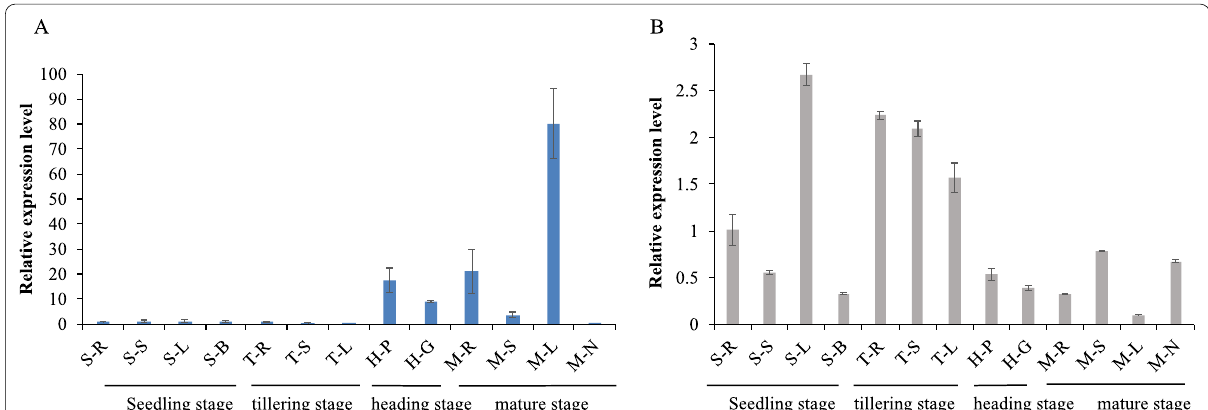
Fig. 1 Analysis of the miR528 and D3 genes expression pattern in rice. A Expression pattern analysis of miR528 in various tissues by qRT-PCR. B Expression pattern analysis of D3 in various tissues by qRT-PCR. S-R, root at the 7-day seedlings; S-S, stem at the 7-day seedlings; S-L, leaf at the 7-day seedlings; S-B, stem base at the 7-day seedlings; T-R, root at the tillering stage; T-S, stem at the tillering stage; T-L leaf at the tillering stage; H-P, Panicles at the heading stage; H-G, glume at the heading stage; M-R, root at the mature stage; M-S, stem at the mature stage; M-L, leaf at the mature stage; M-N, stem node at the mature stage. Data are shown as the means S.D. (n ± =